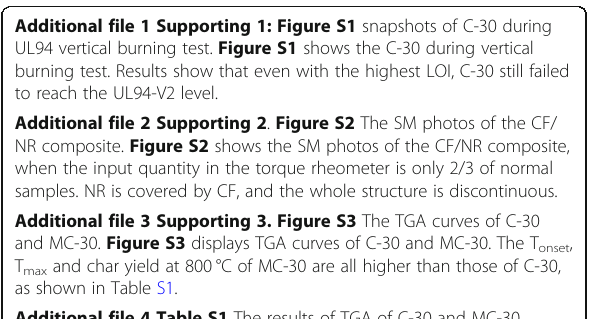
Table 4 The thermal conductivity of NR, C-30 and MC-30 Sample NR C-30 MC-30 Thermal conductivity